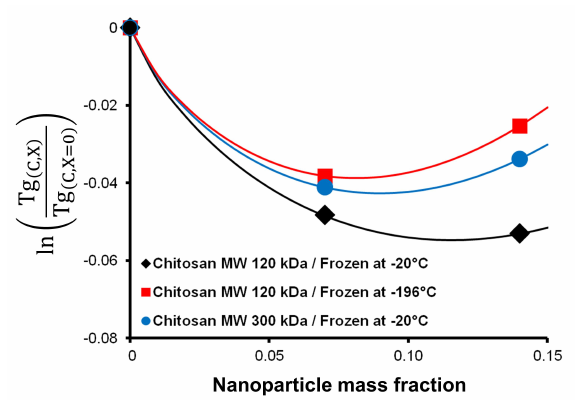
Figure 4. Application of the model to different systems using a fixed crosslinker concentration of 0.10%. Experimental data of the original scaffold (black diamonds), modification of the freezing temperature (red squares) and change of the chitosan molecular weight (blue dots) are